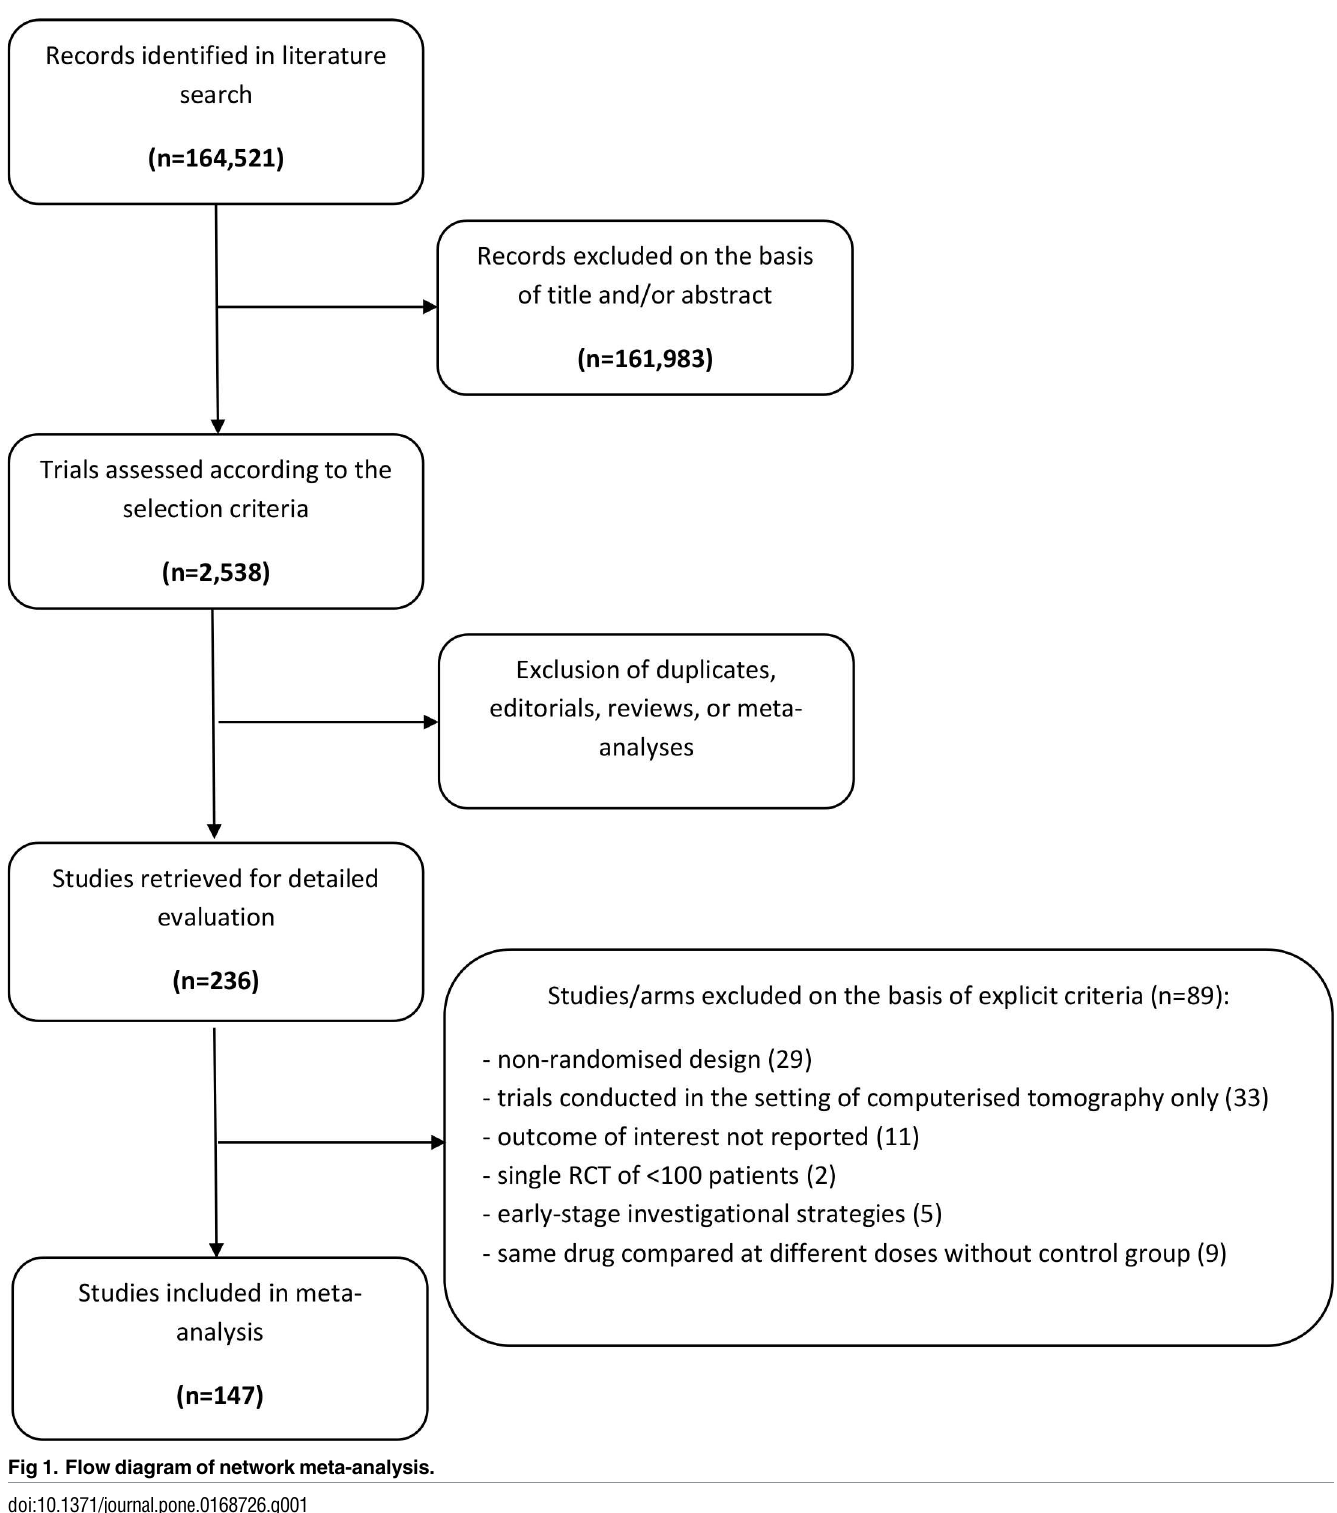
Fig 1. Flow diagram of network